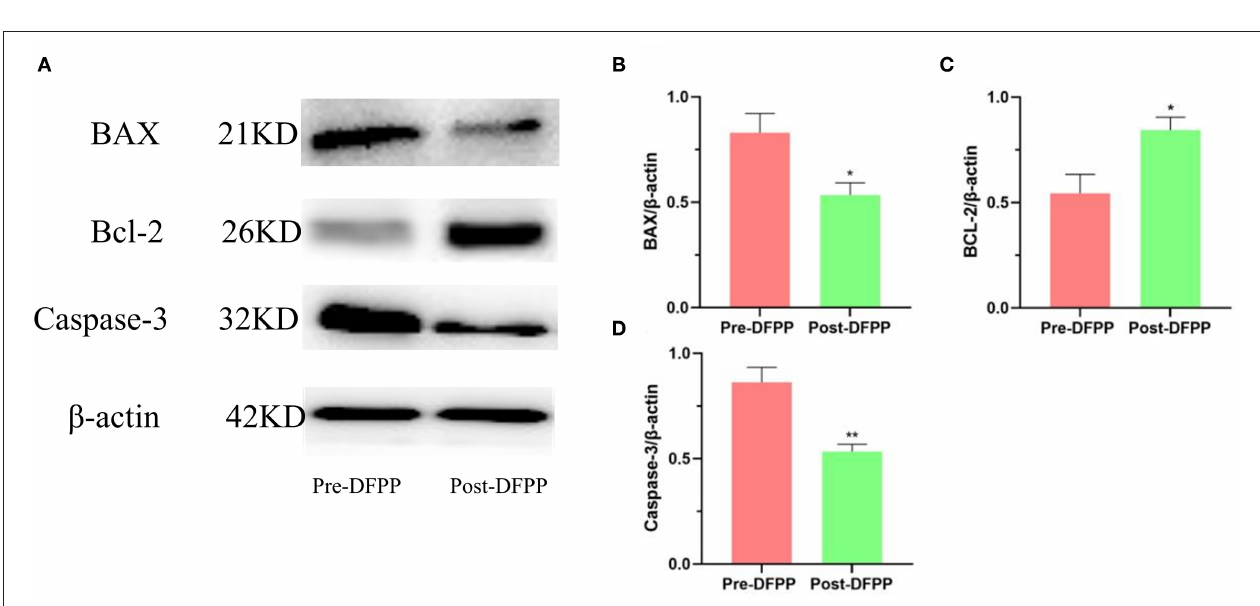
FIGURE 3 | Effects of lipid plasmapheresis on expressions of apoptosis-related proteins. PBMCs protein samples are extracted from patients with high cholesterol and/or high LDL-C. (A) Westernblot result picture of apoptosis-related proteins. Apoptosis-related proteins [Bcl-2 (B) , BAX (C) , Caspase-3 (D) ] in PBMCs were examined by Western blotting analyses. Values were expressed as mean ± SD. * P < 0.05 and ** P < 0.01 vs. pre-DFPP. N =